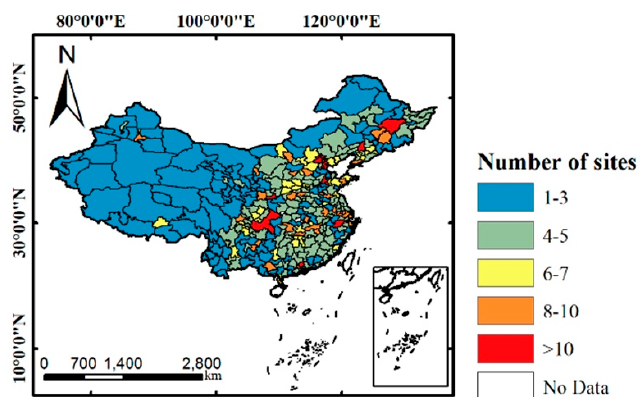
Figure 1. Particulate matter (PM) ground observation sites distribution in China.